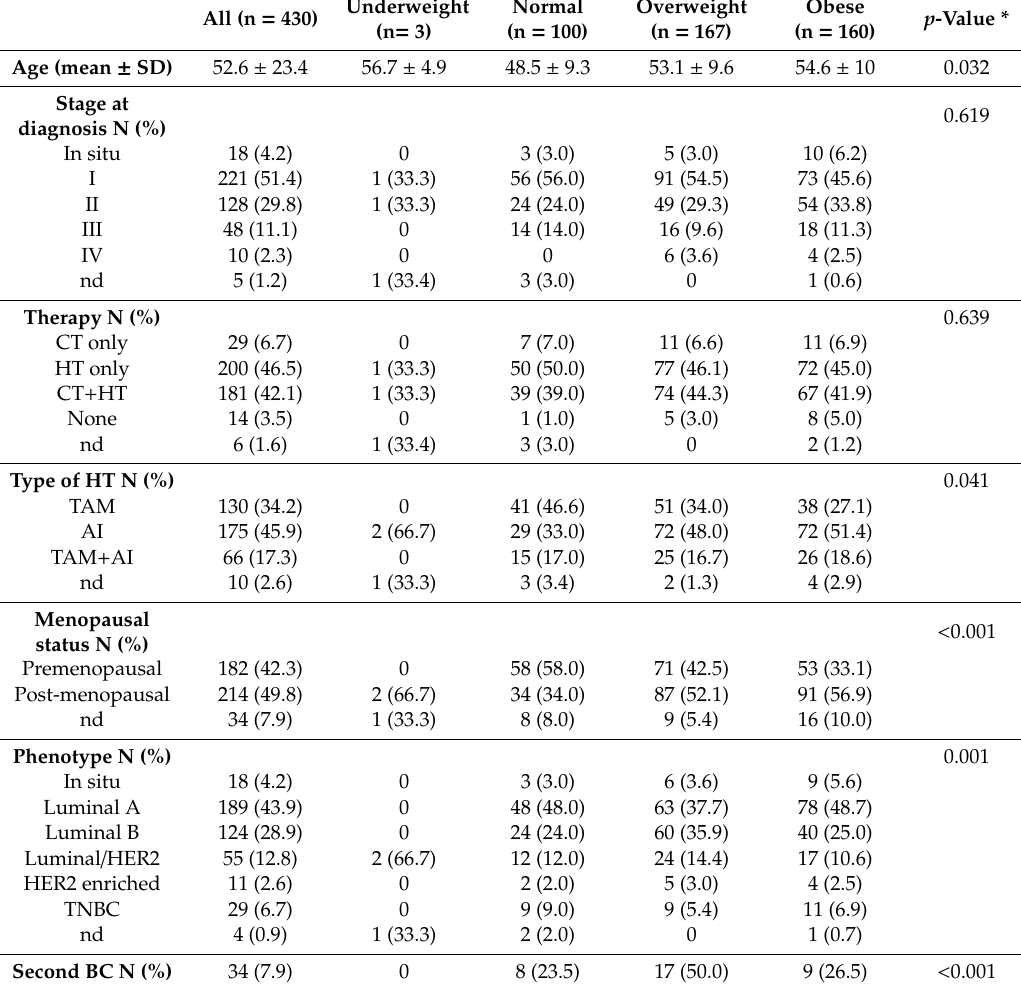
Table 1. Patients’ characteristics at baseline according to BMI